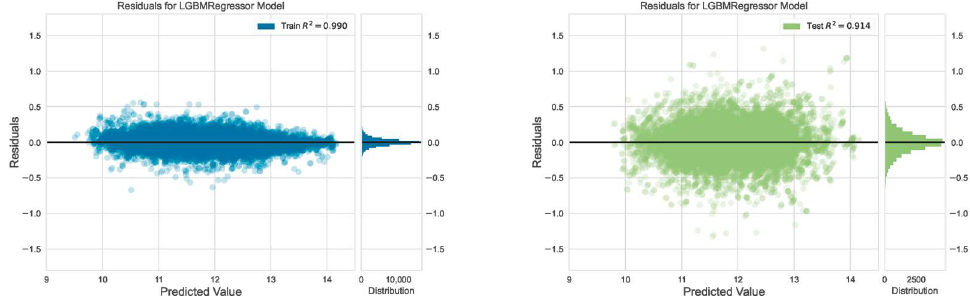
Figure 13. Residual plots of the trained algorithms. Note: Predicted price values on the abscissa axis in a natural logarithm, ordinate axis with standardized errors.